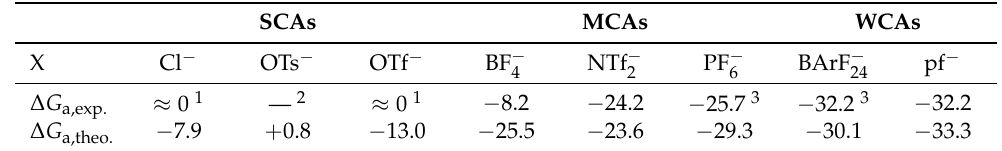
Table 1. Experimental and theoretical ∆ G a values with respect to the involved anion (X), obtained from ITC experiments and calculations at the SMD/M06-2X/def2-TZVP [41–43] level, respectively. All data are given in